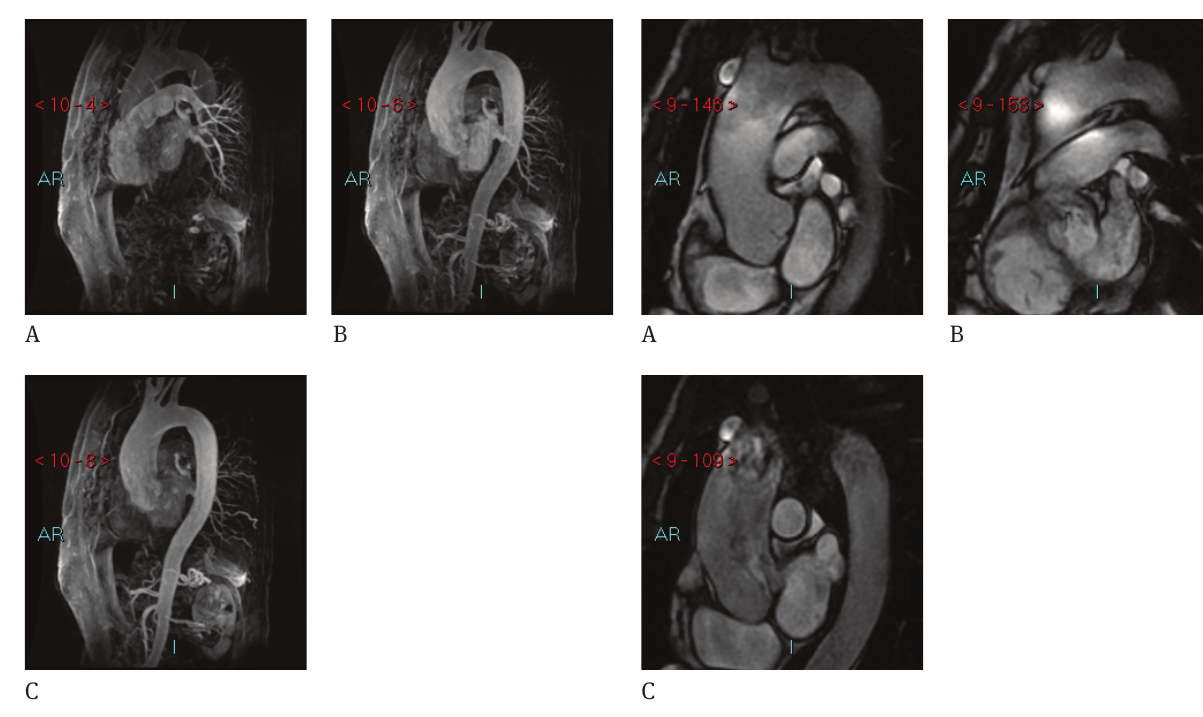
Figure 6: D Gated Steady-state CINE RM provide a natural contrast between the lumen and wall and no pulsatility artifacts are evident. Dimensional evaluation is also possible but by means the analysis in different slices for the ascending aorta, the arch and descending of the coronary arteries also called v-cats. Gated 3D steady